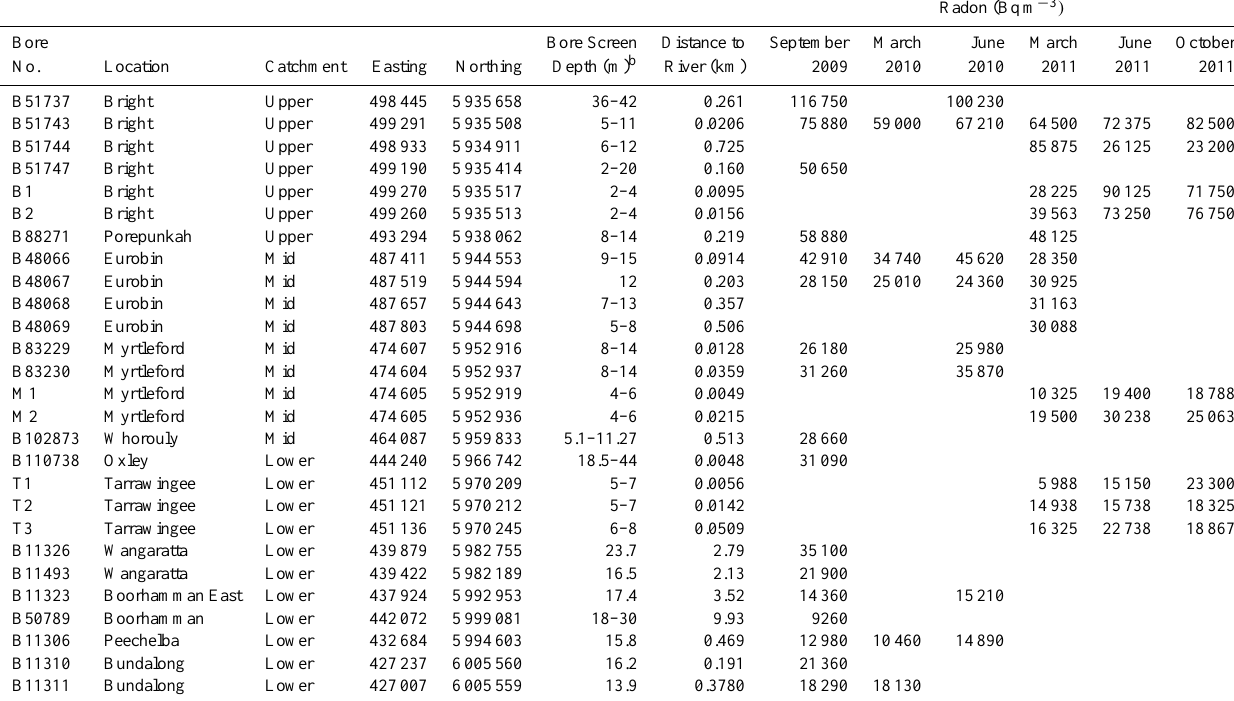
Table 5. 222 Rn activities of groundwater in the Ovens